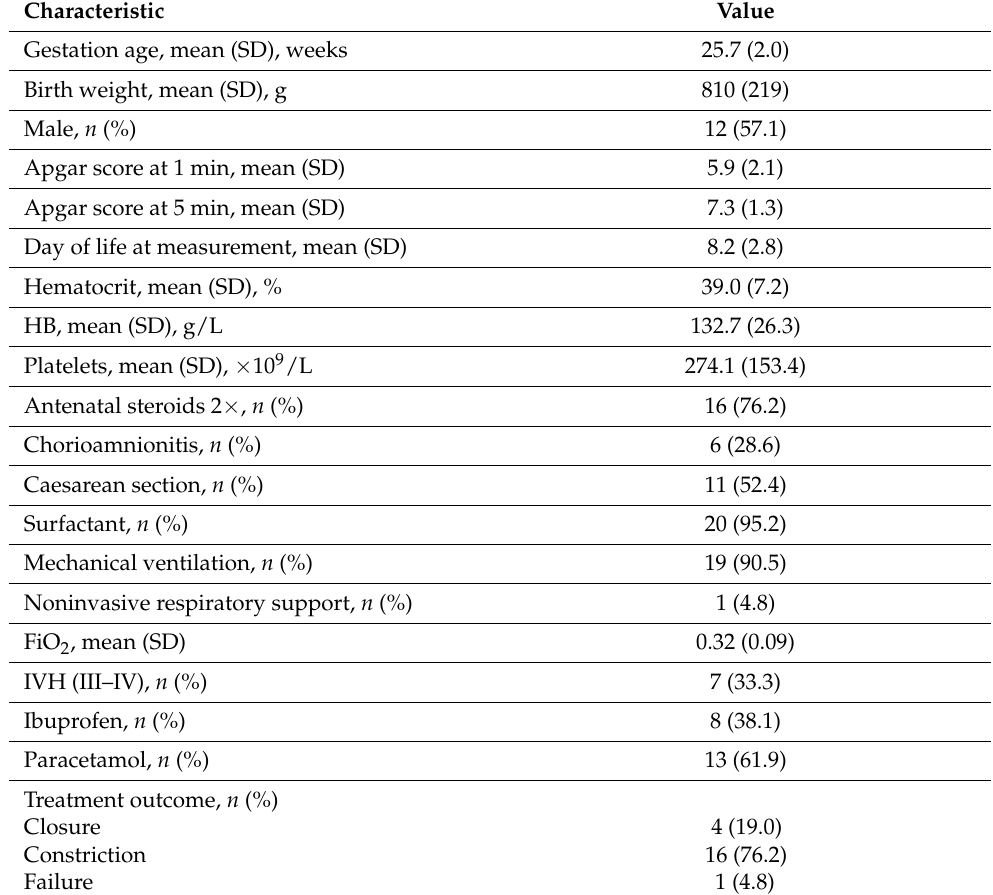
Table 1. Clinical characteristics and outcome data.